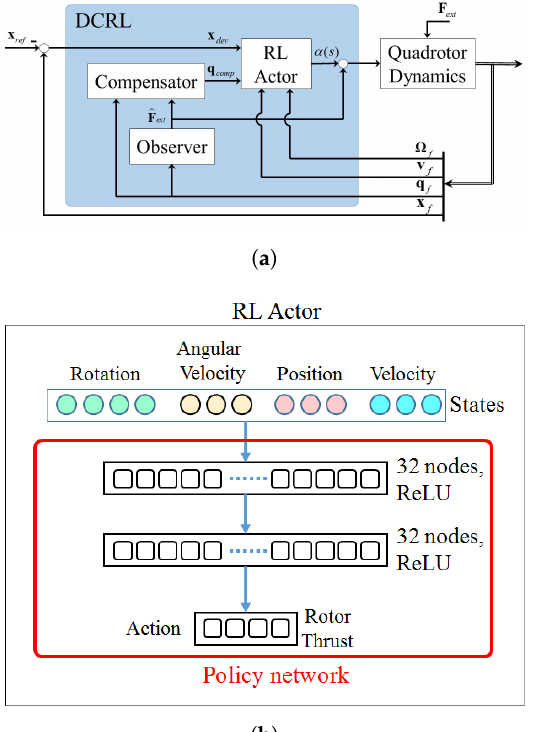
Figure 2. The structures of quadrotor control. ( a ) Block diagram of the quadrotor control structure with reinforcement learning control and external disturbance compensator. ( b ) The neural network in the reinforcement learning (RL)